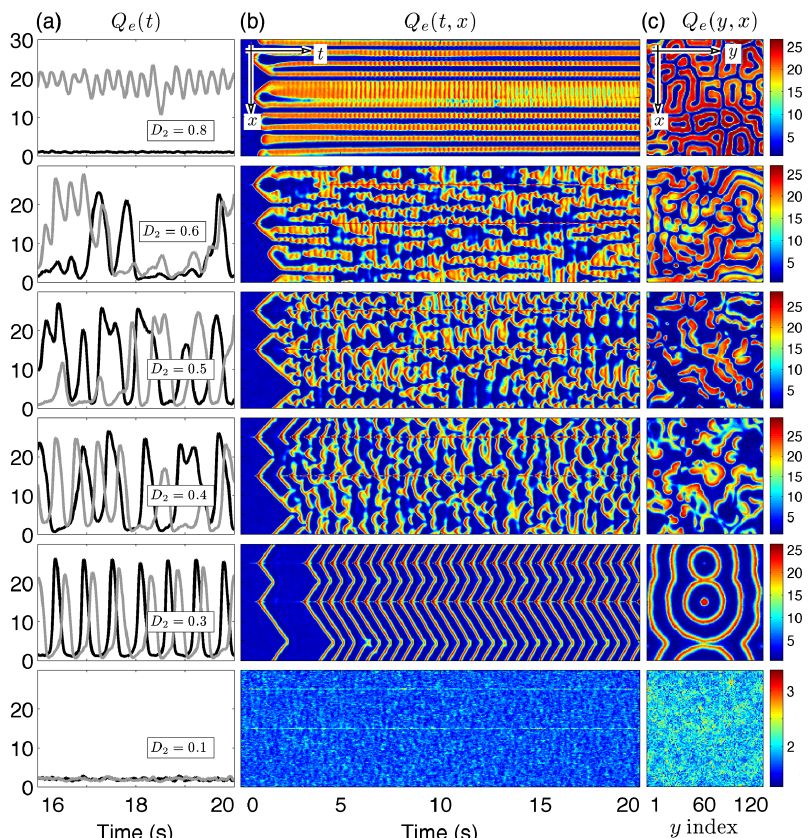
FIG. 8. Effect of inhibitory diffusion on the anesthetic-coma state. Grid simulations are given, initialized at the low-firing coma state of Fig. 3, showing the effect of stepped reductions in inhibitory diffusion strength from D 2 ¼ 0 : 8 (top) to D 2 ¼ 0 : 1 cm 2 (bottom). (a) Time-series extracts showing excitatory firing rates Q e ð t Þ for the final 4 s of a 20-s run at x ¼ 30 (black lines) and x ¼ 105 (gray lines) on the y ¼ 60 midline of the 120 (cid:1) 120 cortical grid. (b) Q e ð t; x Þ space-time charts showing x -axis activity along the y ¼ 60 midline for a full 20-s simulation. (c) Q e ð y; x Þ bird’s-eye image of cortical activity at t ¼ 20 s ; the color bar indicates the firing rate in spikes/s. Points x 1 ¼ 20 and x 2 ¼ 60 on the y ¼ 60 midline are directly connected; see Fig. 5 for the remaining simulation